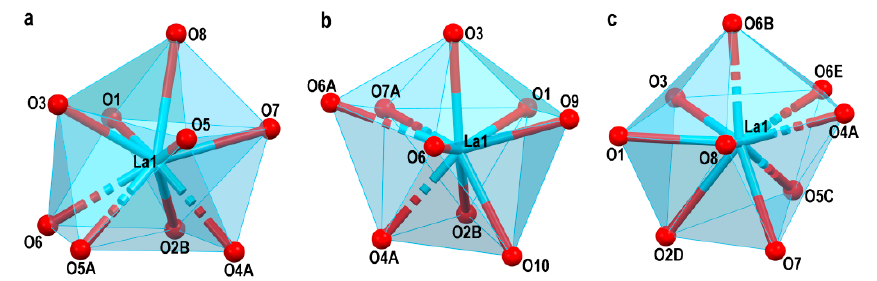
Figure 4. The coordination polyhedron of La cations in 1 ( a ), 2 ( b ) and 3 ( c ).